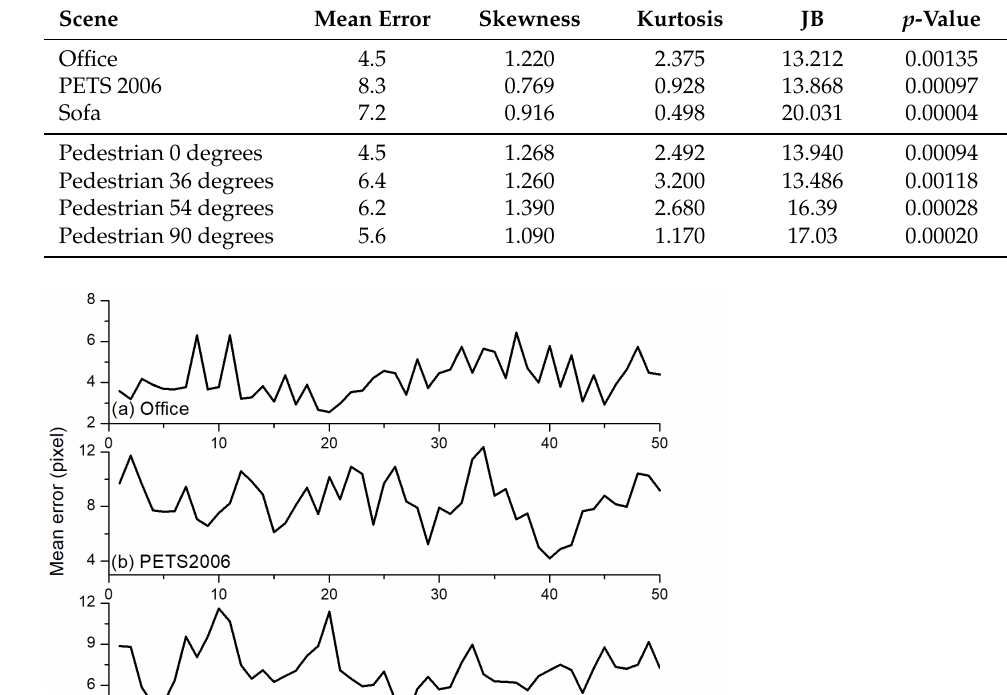
Table 2. Results of the Jarque–Bera test for the selected datasets.